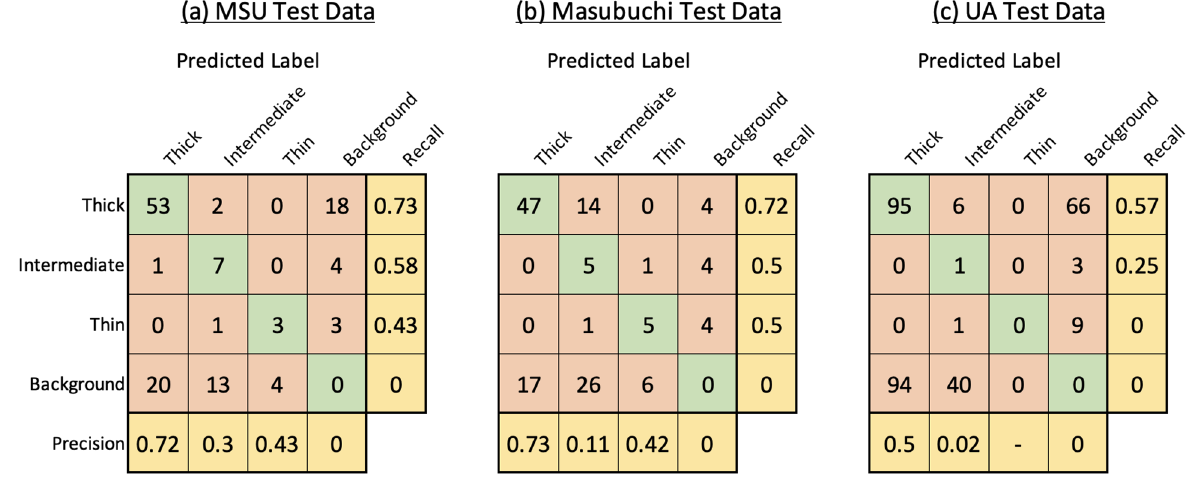
Figure 4. Confusion matrix showing results obtained by applying the proposed algorithm to all three test datasets (MSU, Masubuchi, and